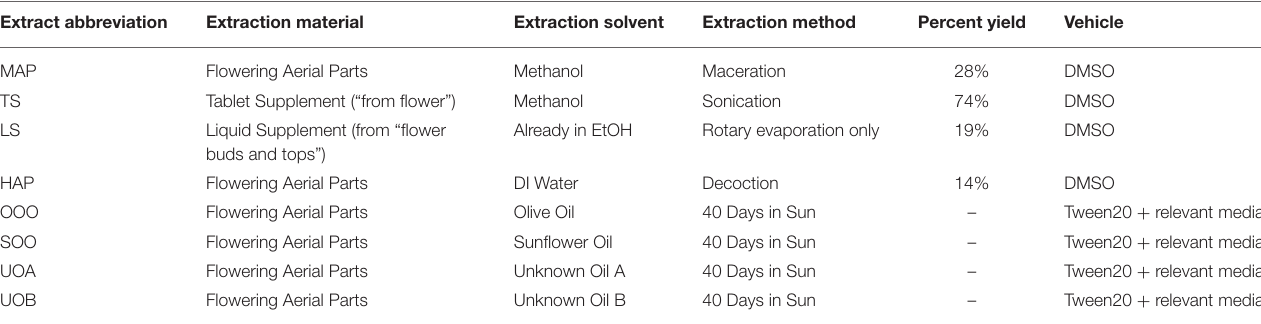
TABLE 1 | Description of extracts made from the flowering aerial parts of Hypericum perforatum